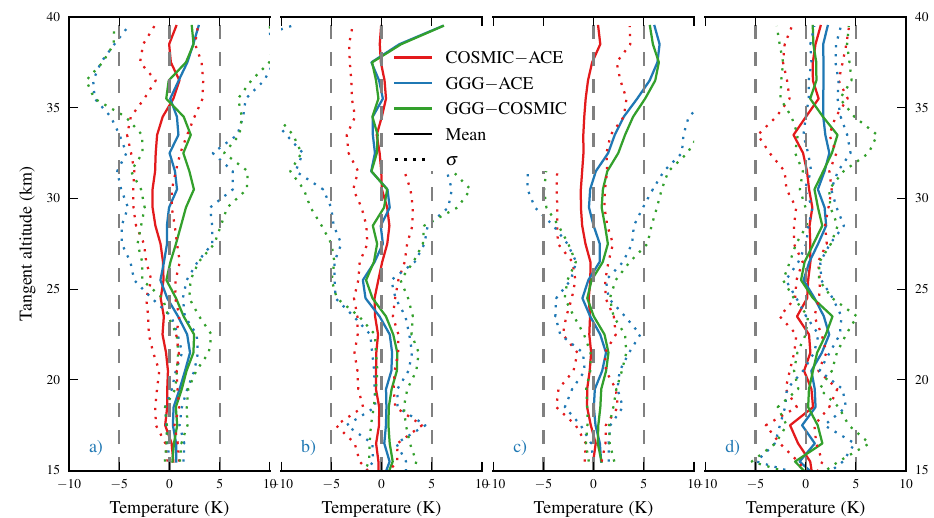
Figure 8. The mean of the differences between temperature profiles retrieved by GGG, ACE-FTS v3.5, and COSMIC for sets: (a) Arctic fall, (b) Arctic winter, (c) Antarctic spring, and (d) low latitudes. Shown are COSMIC − ACE (red), GGG − ACE (blue), and GGG − COSMIC (green). Means are solid lines, and standard deviations are